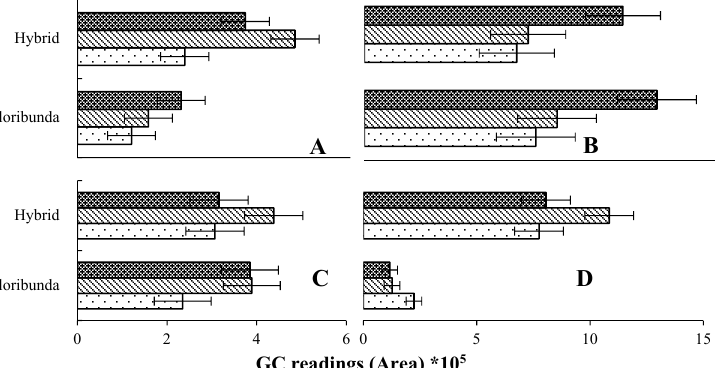
Figure 1. Comparison of main peak area of volatile compounds collected in different rose tissues; ( A ) leaves, ( B ) stems, ( C ) rhizosphere, ( D ) whole plant using different sampling times. 8 weeks, 4 weeks and 2 weeks, bars represent LSD at ( p < 0.05) ( n = 3).